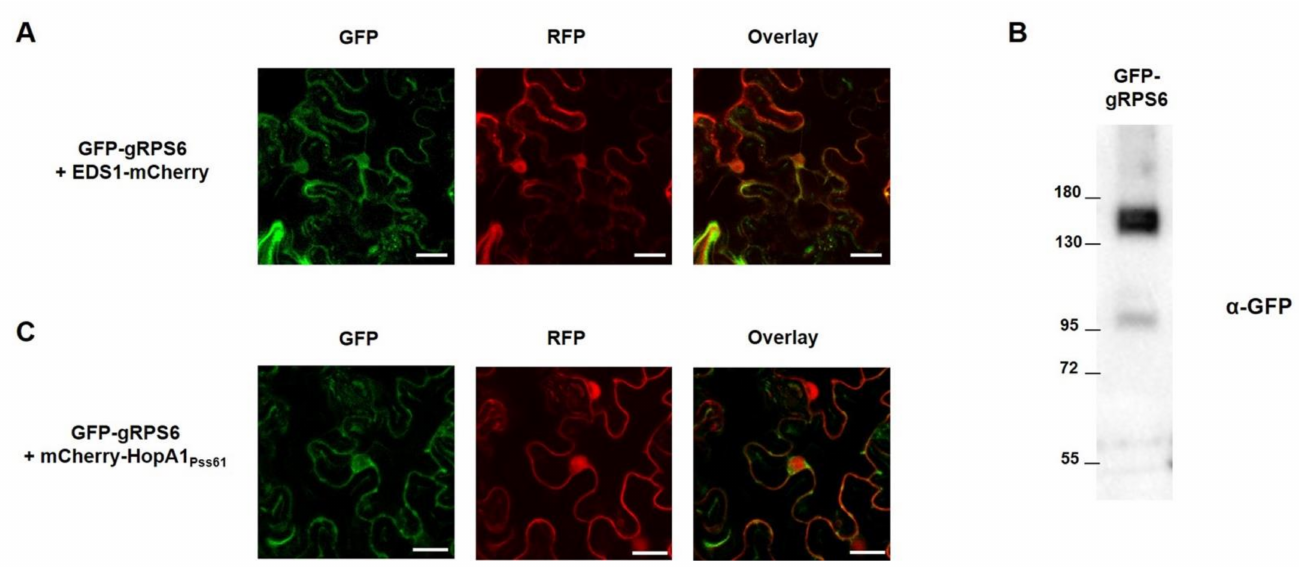
Figure 4. RPS6 localizes to the nucleus and cytoplasm. GFP-gRPS6 was transiently expressed with ( A ) EDS1-mCherry or ( C ) mCherry- HopA1 Pss61 in N. benthamiana leaves using Agrobacterium adjusted to an OD 600 of 0.5 for GFP-gRPS6 and 0.3 for EDS1-mCherry or mCherry- HopA1 Pss61 . Two days after infiltration, cells expressing fusion proteins were analyzed by an Olympus fluoview FV1000 confocal microscope under GFP fluorescence (left), RFP fluorescence (middle), and GFP/RFP overlay (right). Scale bar: 20 µ m. ( B ) Expression of GFP-gRPS6 in samples shown in ( A ) was confirmed by Western blot with anti-GFP